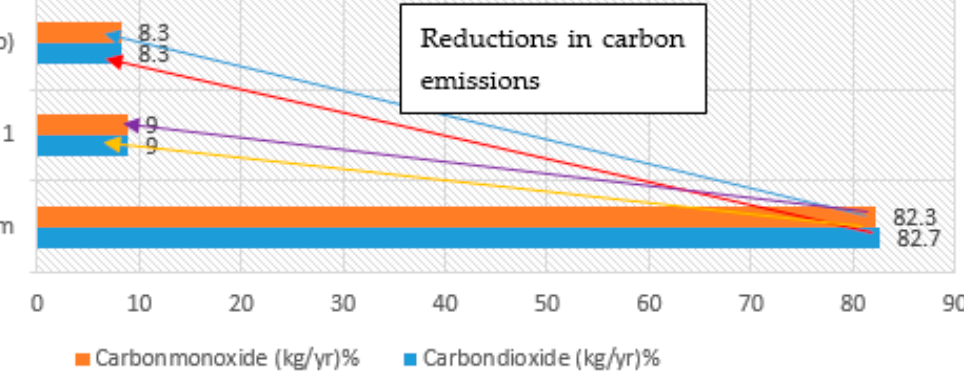
Figure 18. Carbon dioxide and Carbon monoxide